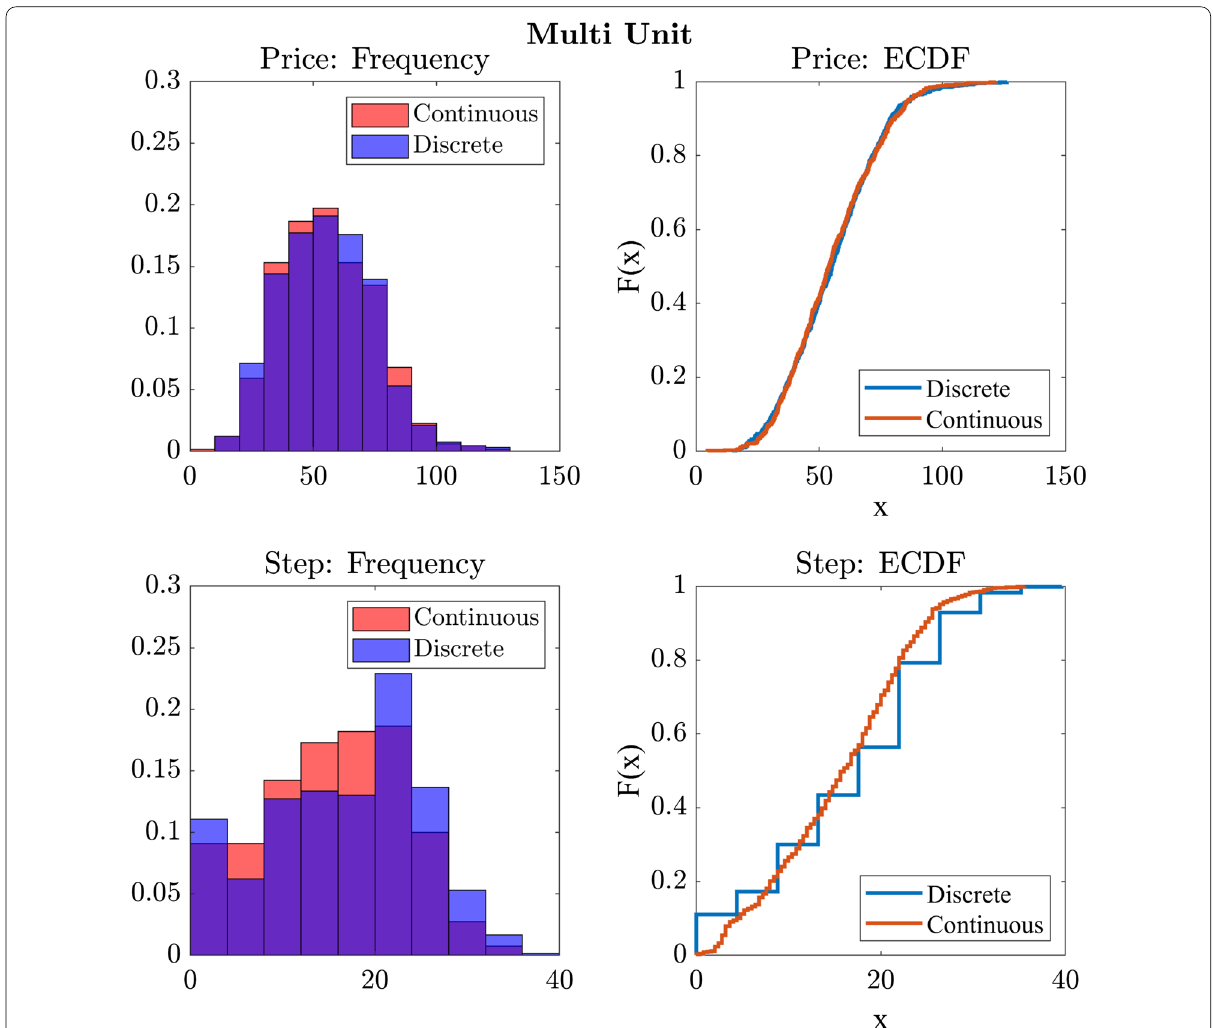
Fig. 11 Exp 2: cumulative distribution functions of price and